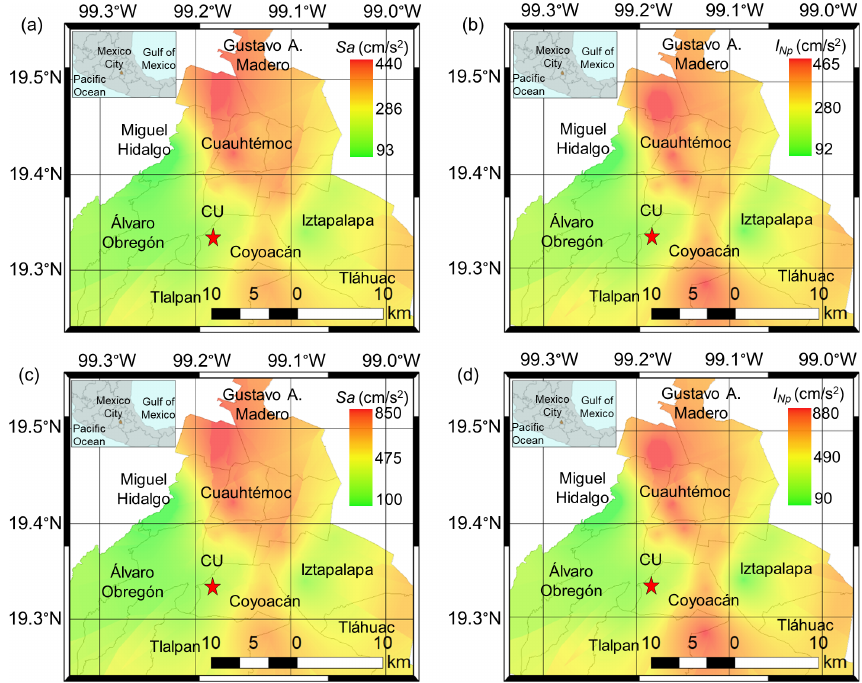
Figure 8. Intensity maps corresponding to Sa( T 1 ) (a, c) and I N